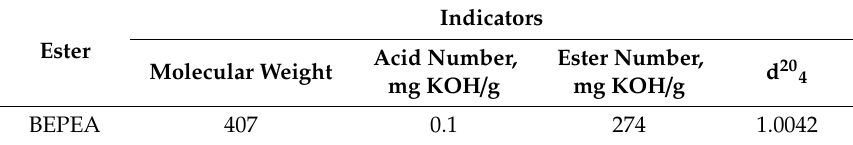
Table 2. Physicochemical properties of butoxyethyl phenoxyethyl adipate (BEPEA). Indicators Ester Molecular